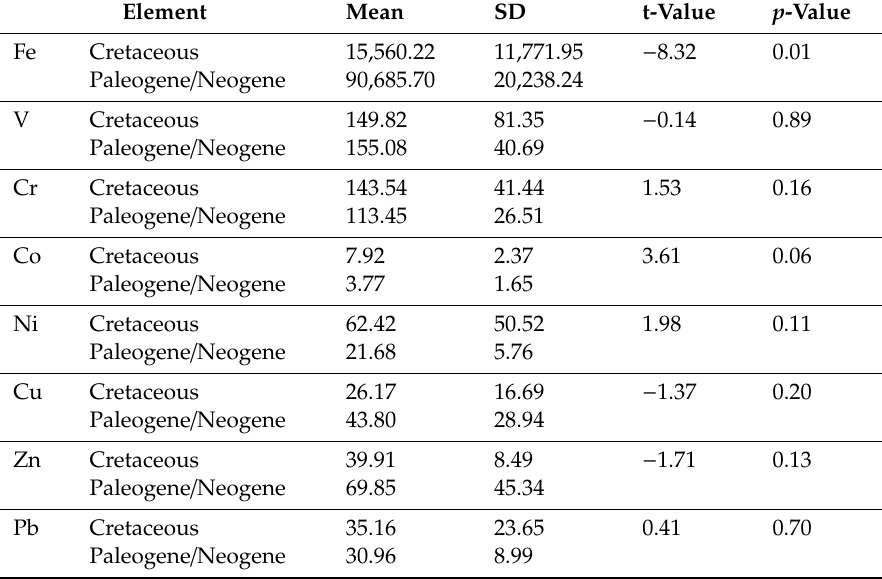
Table 3. T-test for significance of di ff erence in trace element concentrations (mg kg − 1 ) between Cretaceous (n = 6) and Paleogene / Neogene (n = 7) geophagic Kaolinitic Clays from Eastern Dahomey and Niger Delta Basins, Nigeria (at 5% significant level).